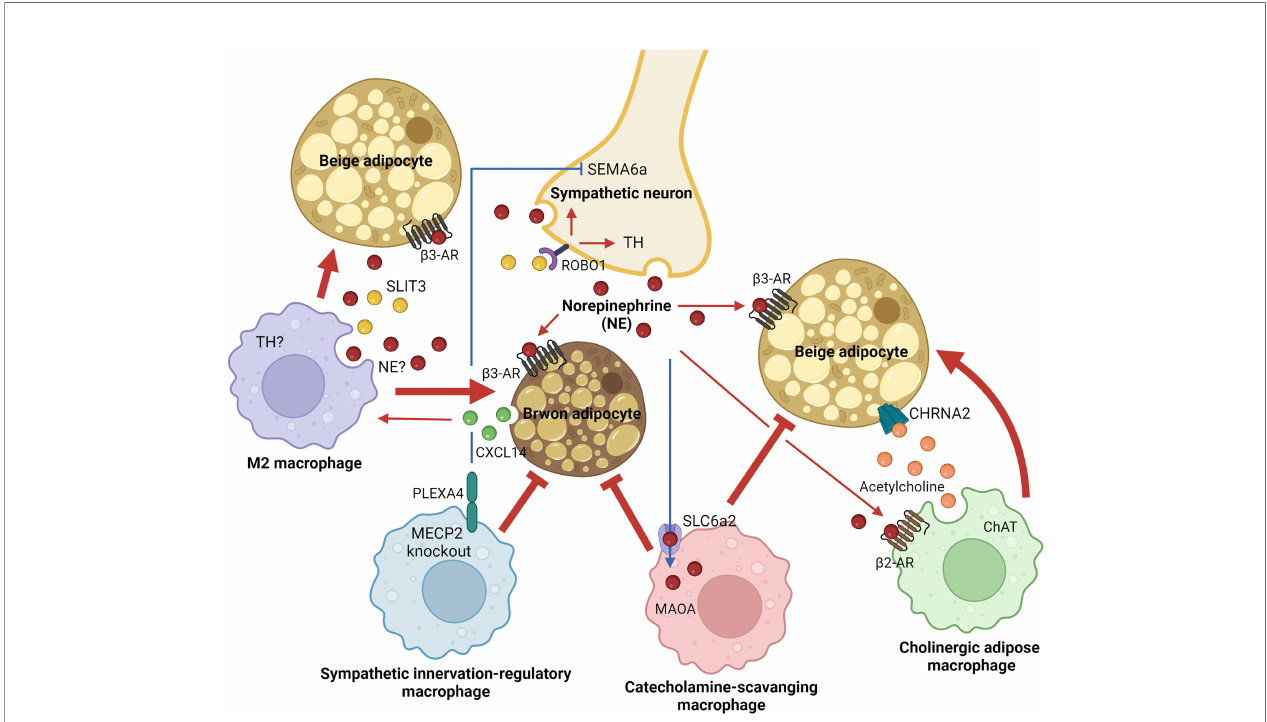
FIGURE 1 | Adipose tissue macrophage-mediated adaptive thermogenesis in brown and beige adipocytes. Distinct macrophage subpopulations within thermogenic adipose tissues, including brown and subcutaneous white fat, support functions of brown or beige adipocytes to dissipate energy and regulate systemic energy homeostasis. Alternatively activated M2 and cholinergic adipose macrophages activate thermogenic responses in brown or beige adipocytes through paracrine mechanisms in a cold environment (red arrows). On the other hand, thermogenic inhibitory ATM subsets that block sympathetic innervation or import/degrade catecholamine have been identi fi ed in thermogenic adipose niches (red blunt-ended lines). AR, adrenergic receptor; ChAT, choline acetyltransferase; CHRNA2, neuronal acetylcholine receptor subunit alpha 2; CXCL14, C-X-C motif chemokine ligand 14; MAOA, monoamine oxidase A; MECP2, methyl-CpG binding protein 2; NE, norepinephrine; PLEXA4, plexin A4; ROBO1, roundabout guidance receptor 1; SEMA6a, semaphoring 6a; SLC6a2, solute carrier family 6 member 2; SLIT3, slit guidance ligand 3; TH, tyrosine